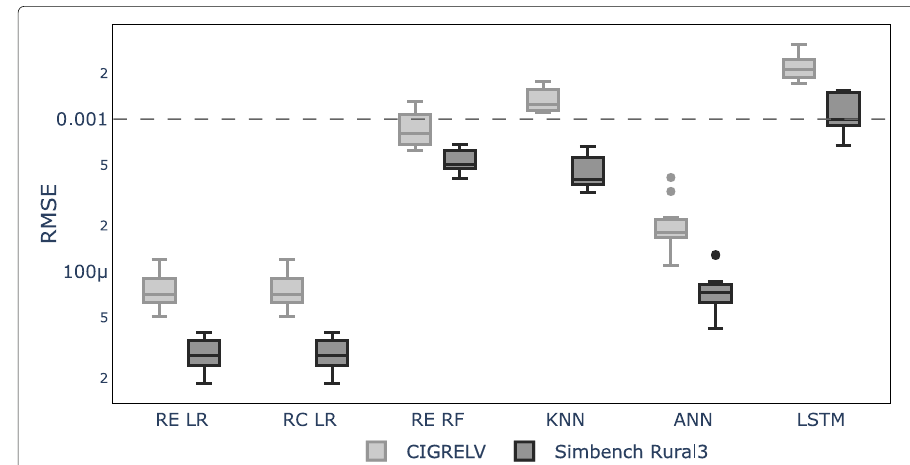
Fig. 1 Monthly RMSE values for the evaluated surrogate models on the LV-rural3 grid model. The results of the CIGRE LV are displayed in lighter gray. The dots mark